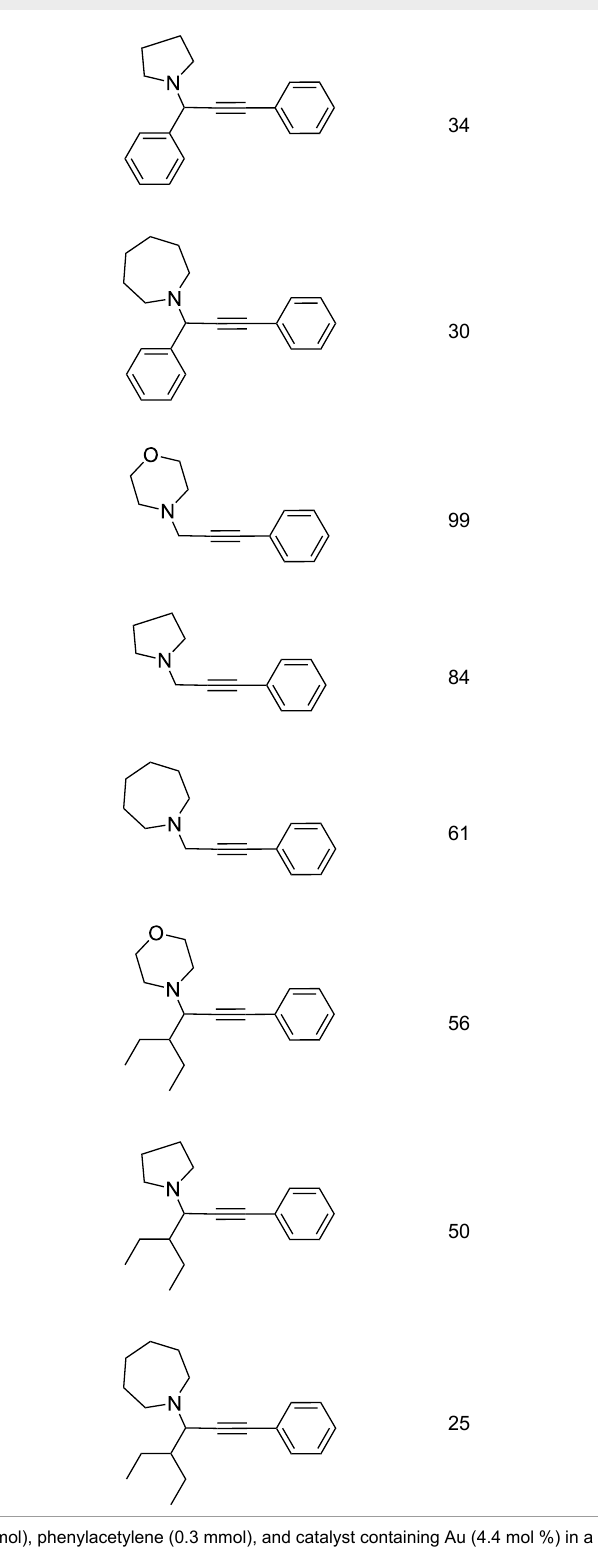
Table 2: Three-component coupling of aldehyde, amine, and phenylacetylene catalyzed by Au@SH-CNC catalysts in solvent-free conditions. a